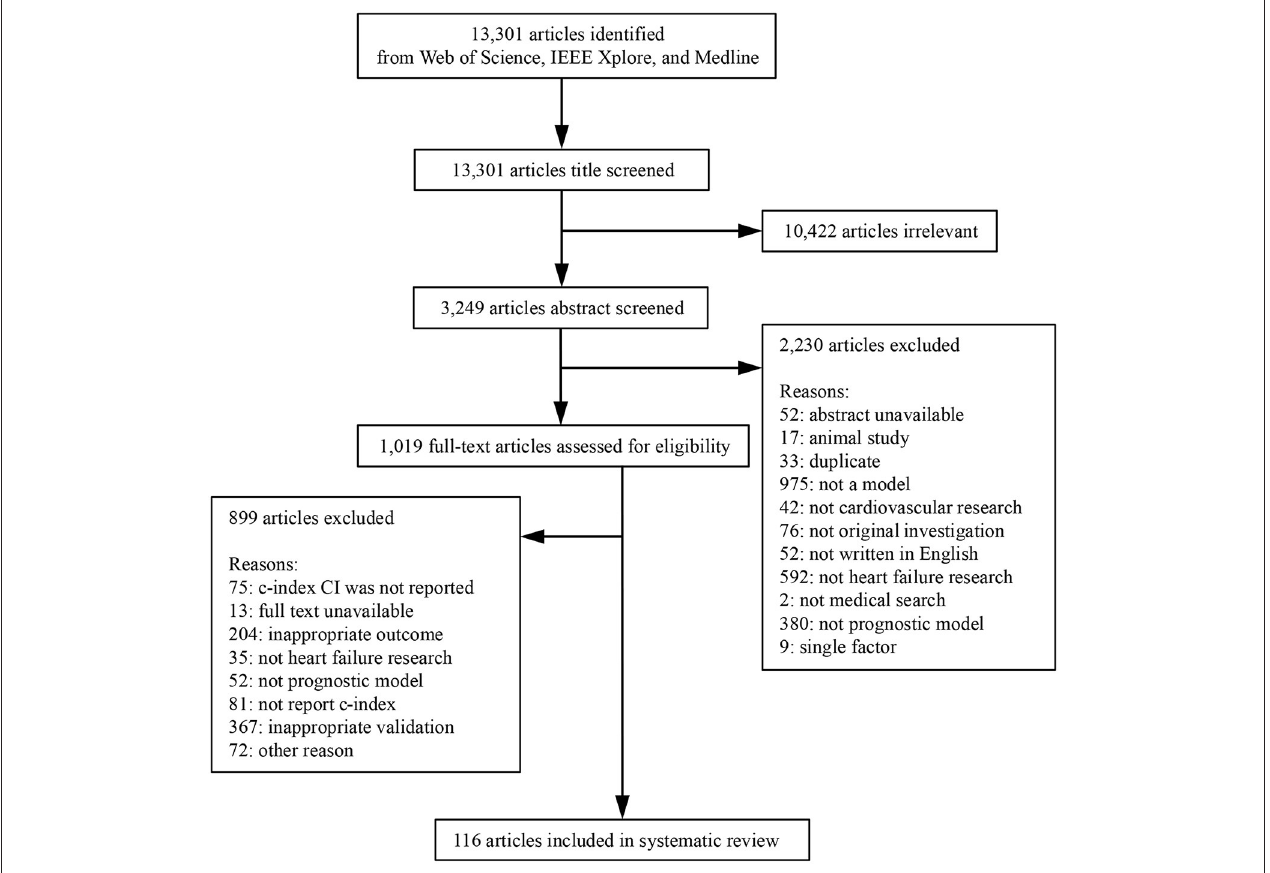
FIGURE 1 | Literature selection